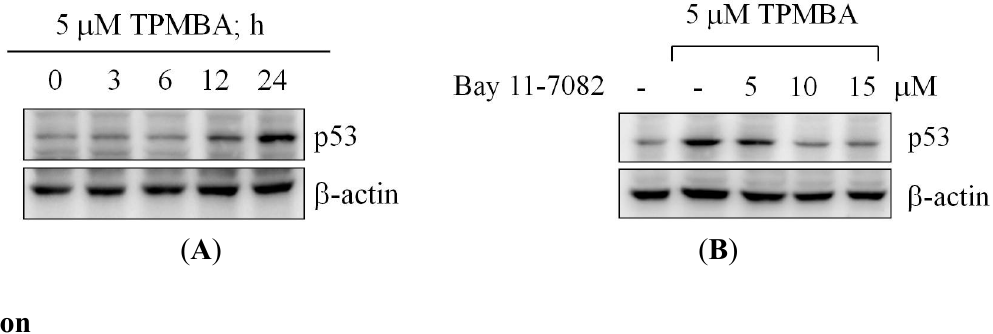
Figure 6. Regulation of p53 expression depends on NF- κ B signaling pathway. ( A ) The time-dependent effect of TMPBA on p53 expression. MCF-7 Cells were exposed to TMPBA intoTMPBAin 10%FBS-supplemented DMEM for the indicated time intervals. The cell lysates were analyzed by western blotting with antibodies for p53 and β -actin. The p53 protein expression level was quantified densitometrically; ( B ) The effect of the pharmacological inhibitor of NF- κ B, Bay 11-7082, on TMPBA-induced p53 expression. Cultures of MCF-7 cells were treated with 5 µM TMPBA in the presence of Bay 11-7082. The p53 protein expression level was quantified